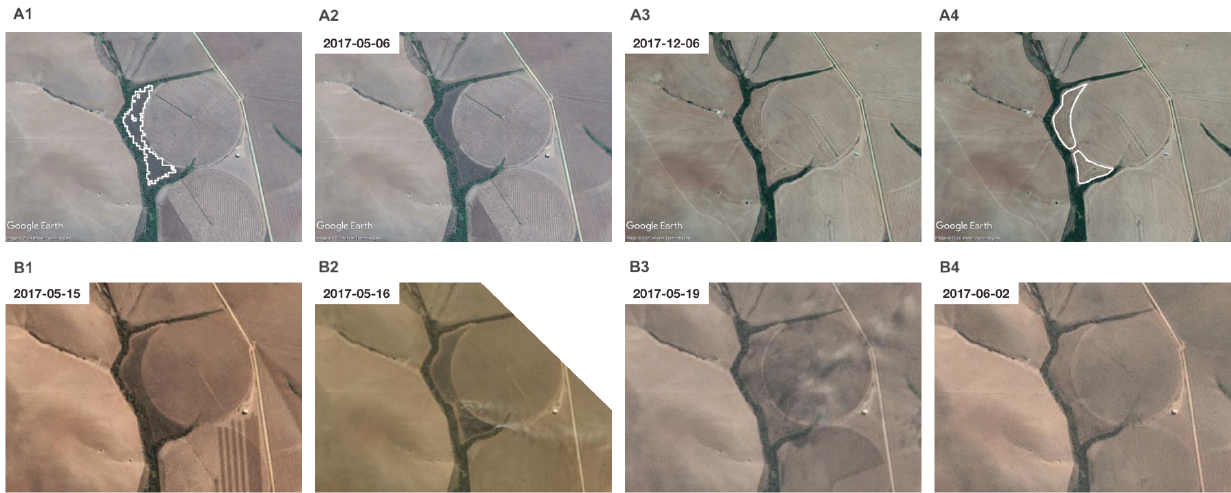
Figure 2. Outline of the methodology used for ( A ) accurate mapping of Renosterveld loss and ( B ) obtaining dates for the occurrence of change events. The output from a random forest classification outlines an area of potential Renosterveld loss ( A1 ). Very-high resolution Google Earth imagery confirms the presence of Renosterveld on 6 May 2017 ( A2 ) and its absence on 6 December 2017 ( A3 ). With the help of very-high resolution imagery an accurate outline of the areas lost is obtained ( A4 ). The time-series of PlanetScope imagery confirms 15 May 2017 as the last day that the presence of Renosterveld can be confirmed ( B1 ). Vegetation removal is ongoing on 16 May 2017, suggested by the presence of smoke ( B2 ). By 19 May 2017, no Renosterveld remains ( B3 ), and this is confirmed by later imagery from 2 June 2017 ( B4